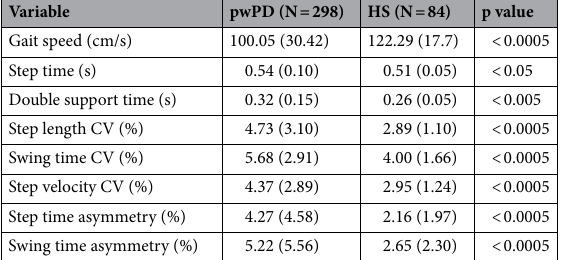
Table 2. Mean values of the eight gait variables (± SD) in the patients with Parkinson’s Disease (pwPD) and healthy subjects (HS).